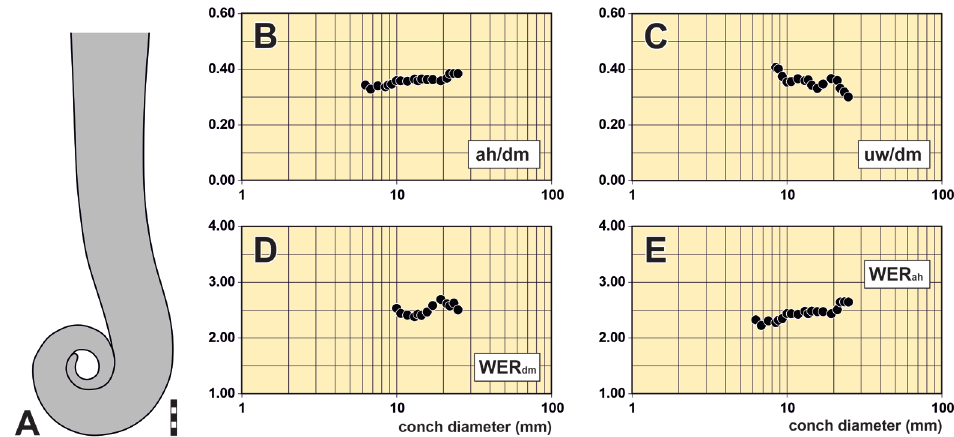
Fig. 55. Lituites baculus sp. nov. A . Outline of coiled conch part of holotype MB.C.29654. B–E . Conch proportions and coiling rates of holotype MB.C.29654. Scale bar units = 1